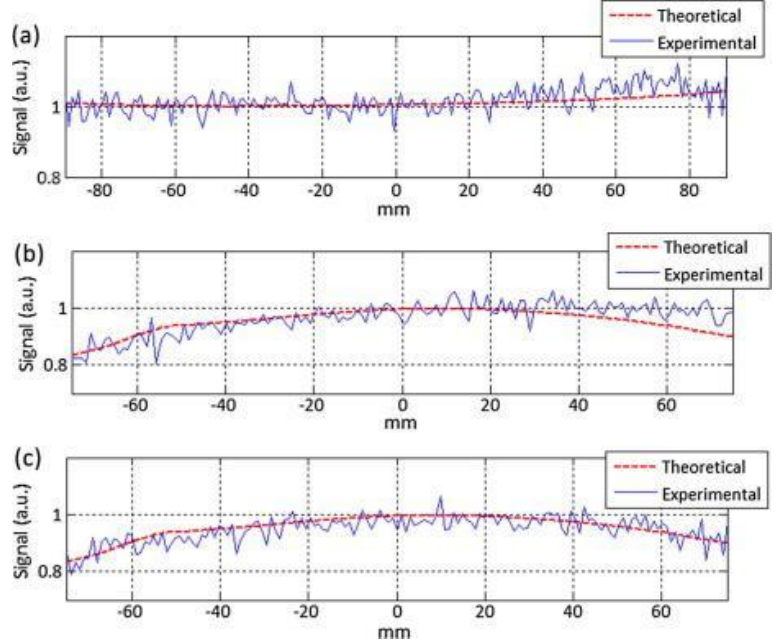
Figure 6. Spine volume-coil signal profiles extracted from MR images and full-wave simulations: ( a ) axial, ( b ) coronal, and ( c ) sagittal view. Reprinted from [42].